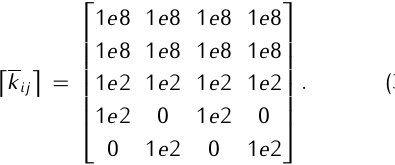
Table 7. The first eight natural frequency parameters of angle-ply plates ( translation, (